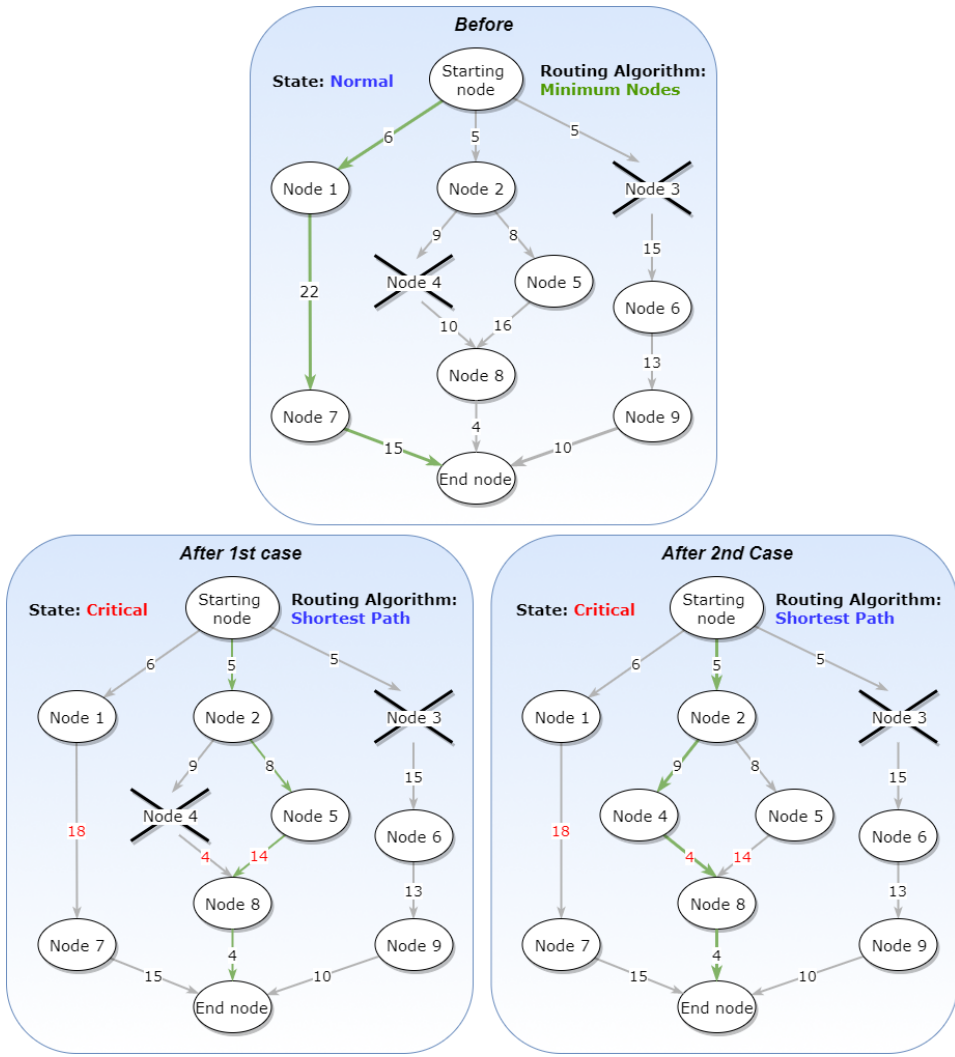
Figure 20. Constraints Use